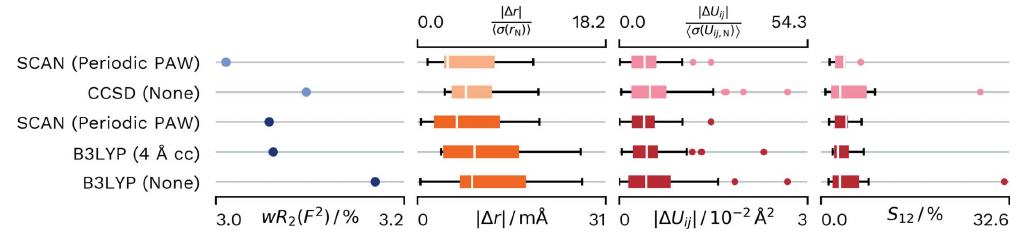
Figure 4 Differences in wR 2 ( F 2 ) and agreement with neutron values for different density sources for HAR of A23 . Distributions of parameters are displayed as box-whisker plots. SCAN (Periodic PAW) was conducted with our script and GPAW . The CCSD (None) values are from the reference calculation from the literature (Wieduwilt et al. , 2020). B3LYP (4 A˚ cc) uses 4 A˚ of cluster charges and was refined with NoSpherA2 / TONTO . B3LYP (None) was calculated with NoSpherA2 / ORCA without any approximation of the crystal environment. Lighter coloured datasets have an F / (cid:2) ( F ) cut-off of 3 as applied in the reference.